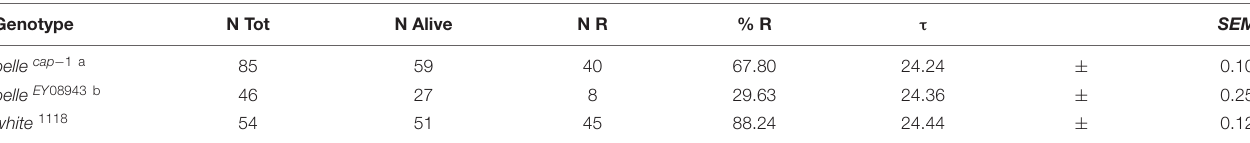
TABLE 4 | Locomotor activity of belle mutants in constant darkness